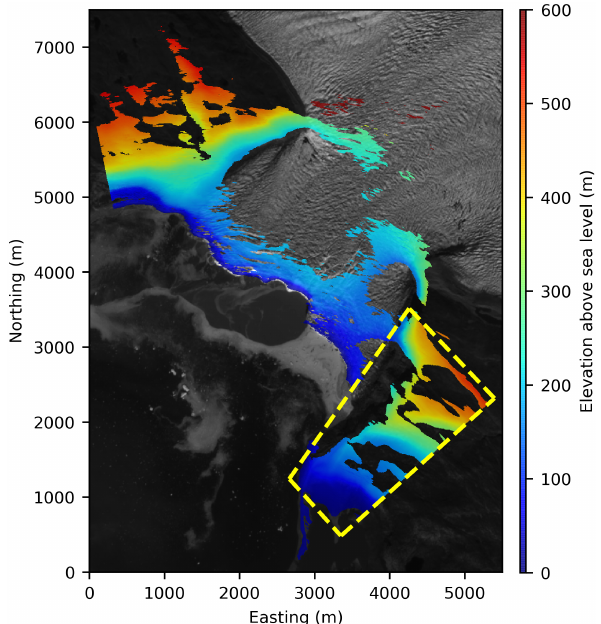
Figure 3. TRI-derived DEM stacked over 60min. The yellow square marks the stable terrain area where the mean variability was investigated. The origin of the coordinate system corresponds to 7739550 ◦ N, 527350 ◦ E (UTM 22 ◦ N). Background: Sentinel-2A scene from 3 August 2016 (from ESA Copernicus Science Hub: https://scihub.copernicus.eu, last access: 14 August